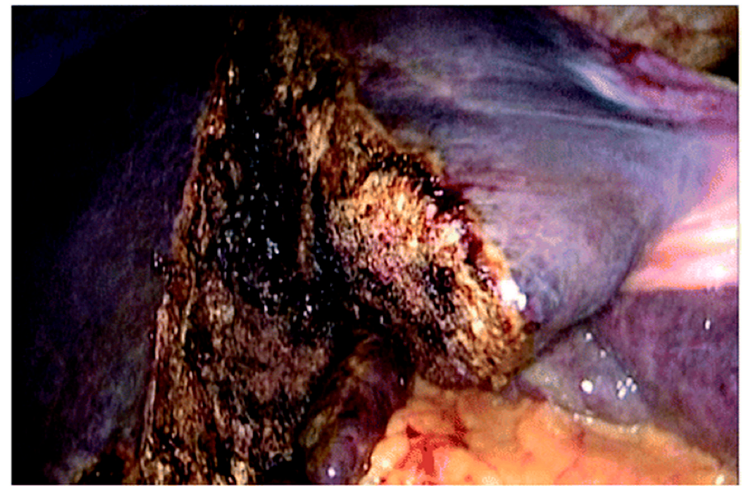
Figure 1. Intraoperative view of Split in situ during laparoscopic partial ALPPS.